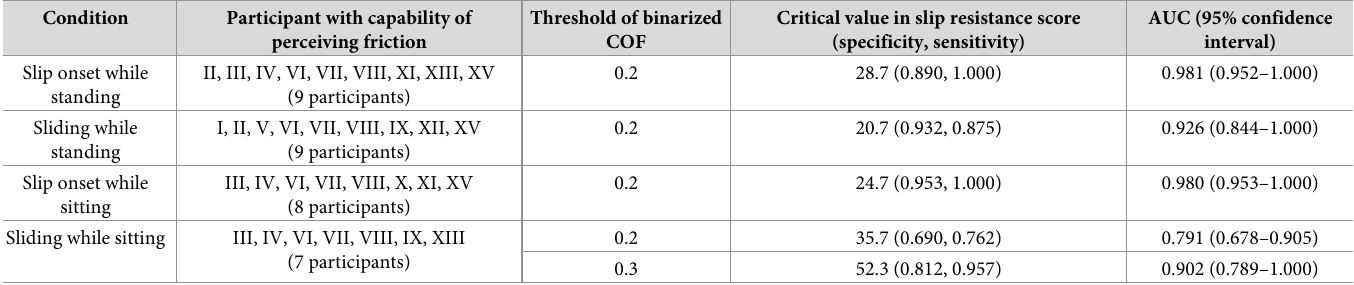
Table 3. Details of ROC analysis associated with Fig 7.